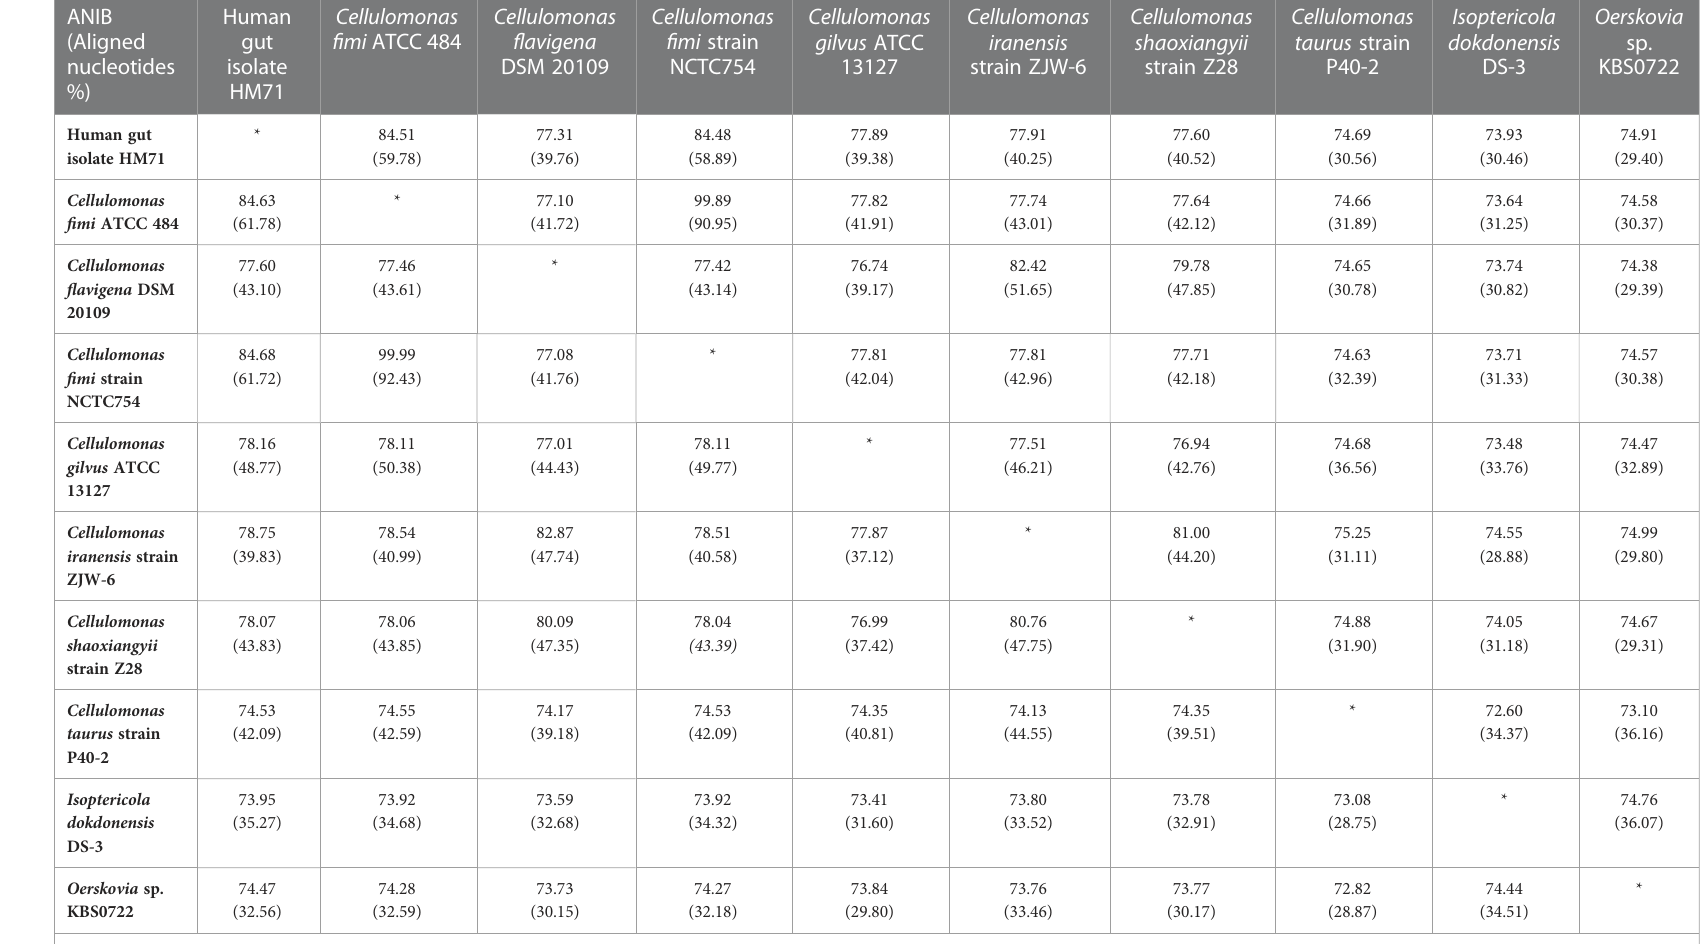
TABLE 3 Average Nucleotide Identity (ANI) of Cellulomonas sp. HM71 with reference to other Cellulomonas species.